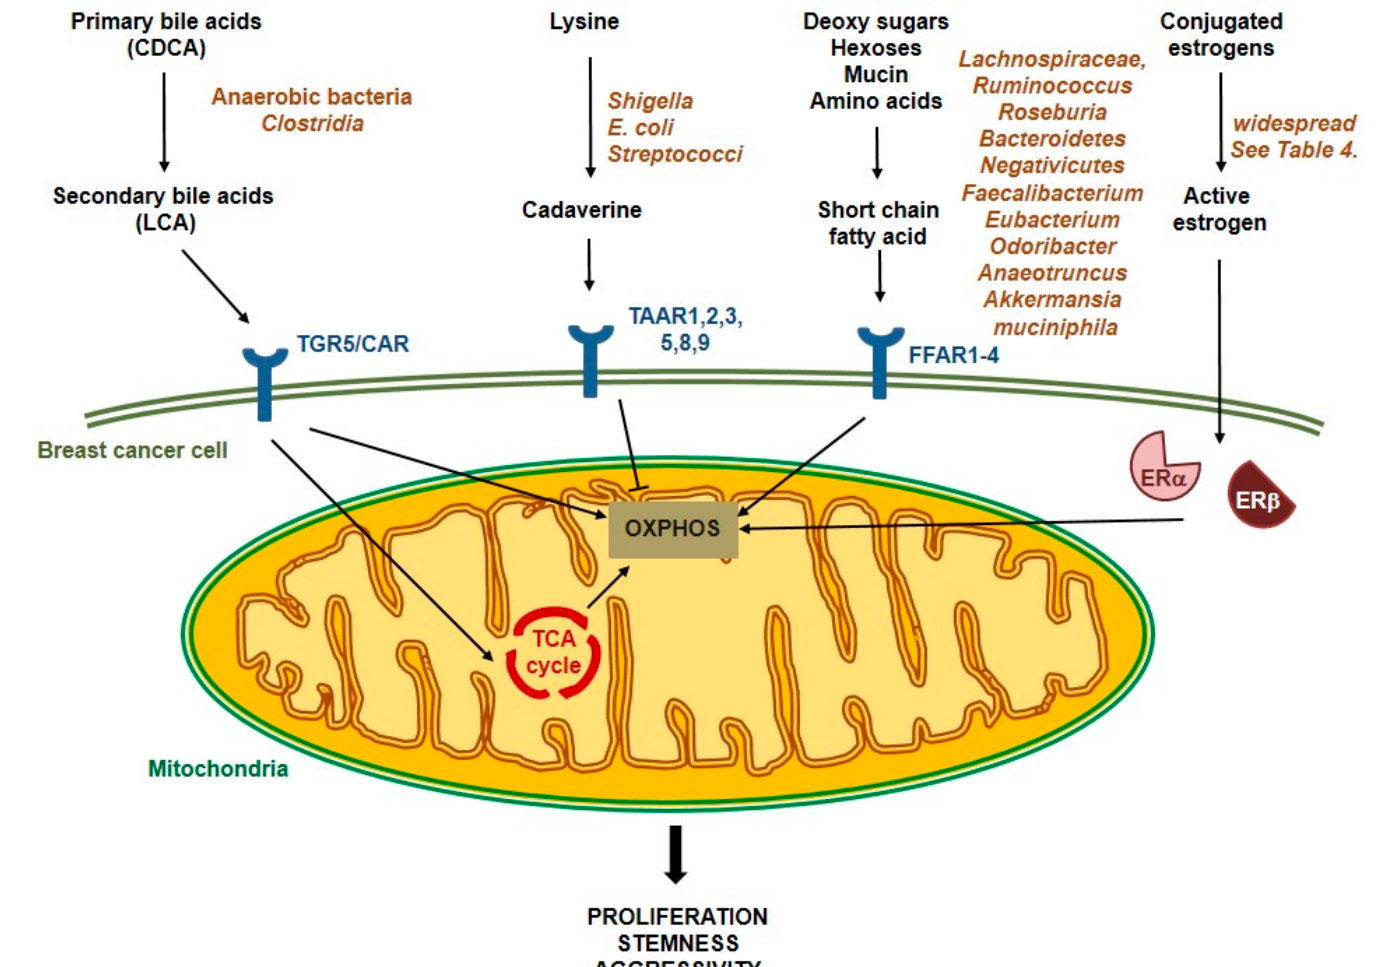
Figure 1. Schematic representation of the pathways elicited by bacterial metabolites that modulate mitochondrial metabolism in breast cancer.